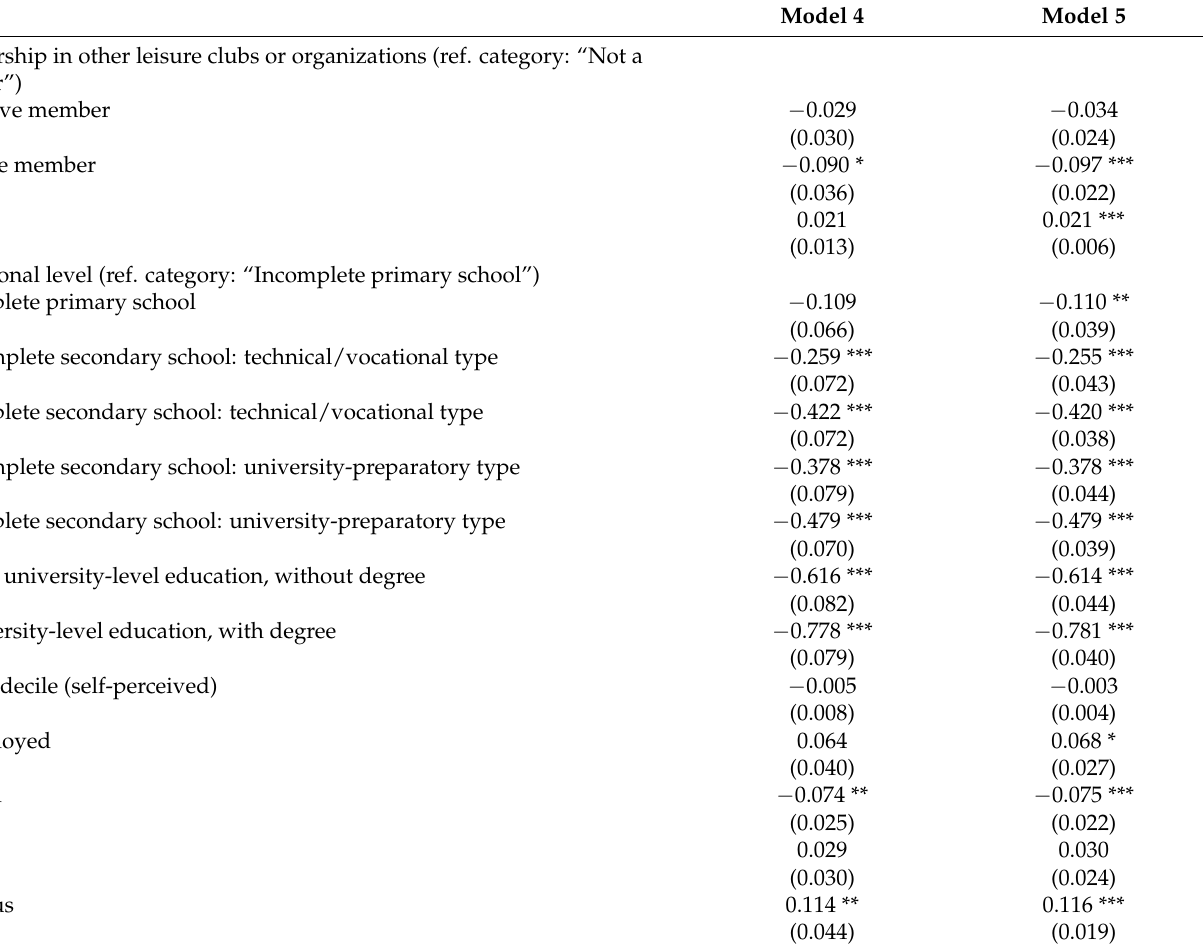
Table A1. Partial effects of sports participation on sexist gender ideologies moderated by the deciles of the WPE Index (Model 4) and the deciles of EG Index (Model 5). Random coefficient models based on male observations from 74 countries. Source: WVS-EVS-data and V-Dem